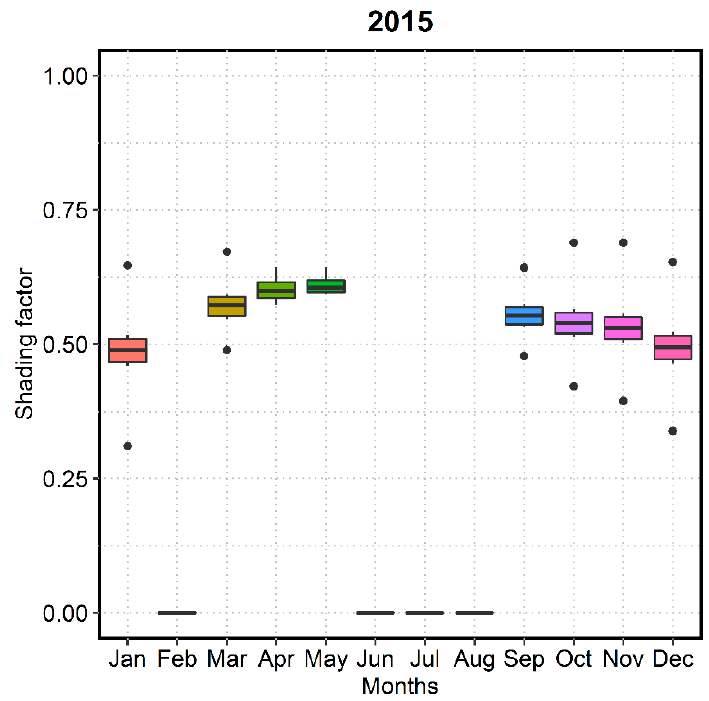
Figure 7. Shading factor to limit the energy performance gap to ±5% (example for the year 2015).